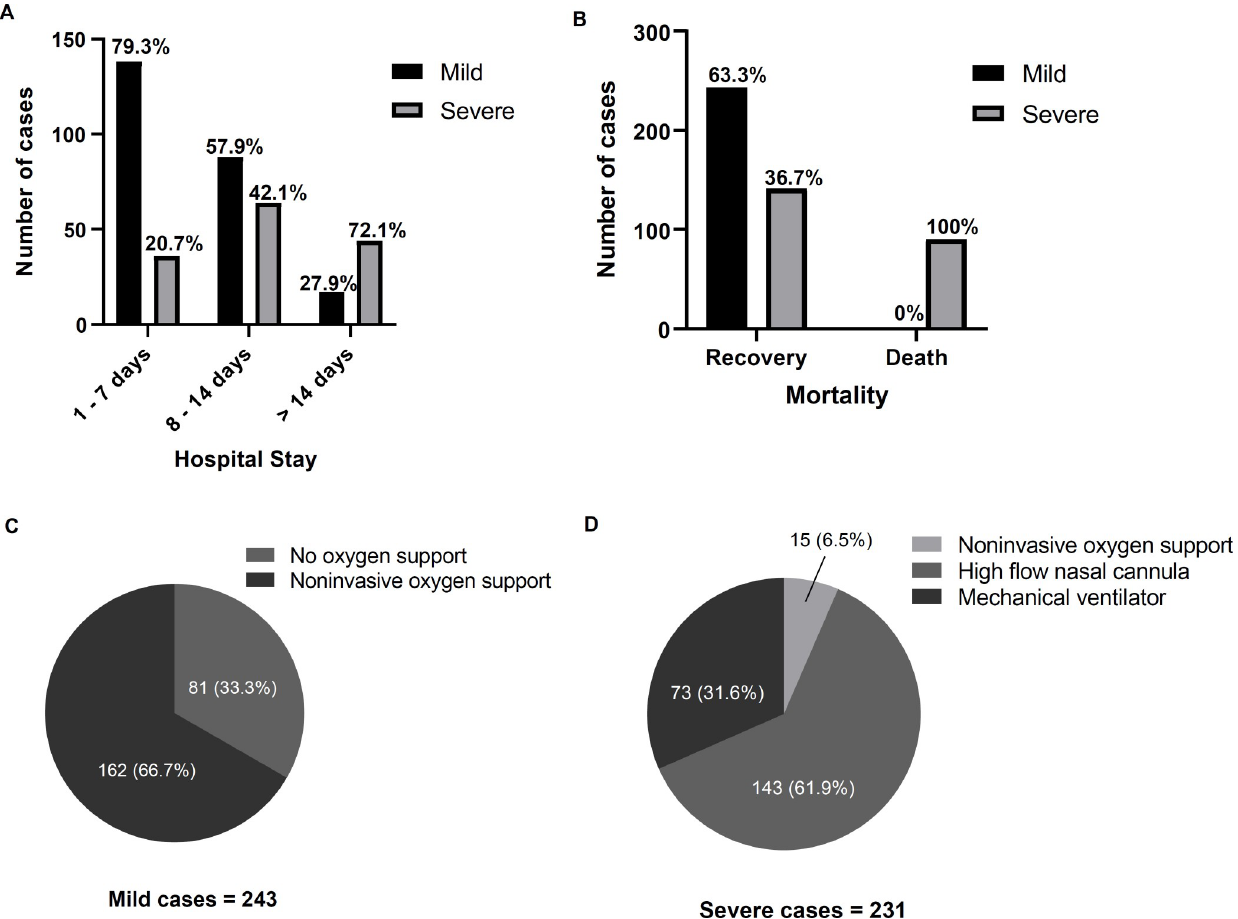
Fig 1. Mortality and oxygen support requirements in mild and severe COVID-19 infection. (A) Comparison of the length of hospital stay for mild and severe cases. The hospital stay of this study was divided into three groups: 1–7 days, 8–14 days and more than 14 days. (B) The mortality was compared, i.e., recovery and death in mild and severe COVID-19 infections. (C and D) The pies of oxygen support types used in these patients. The significance was determined using Mann-Whitney U test � P � 0.05, �� P � 0.01 ��� and P � 0.001 (compared with data in mild cases).